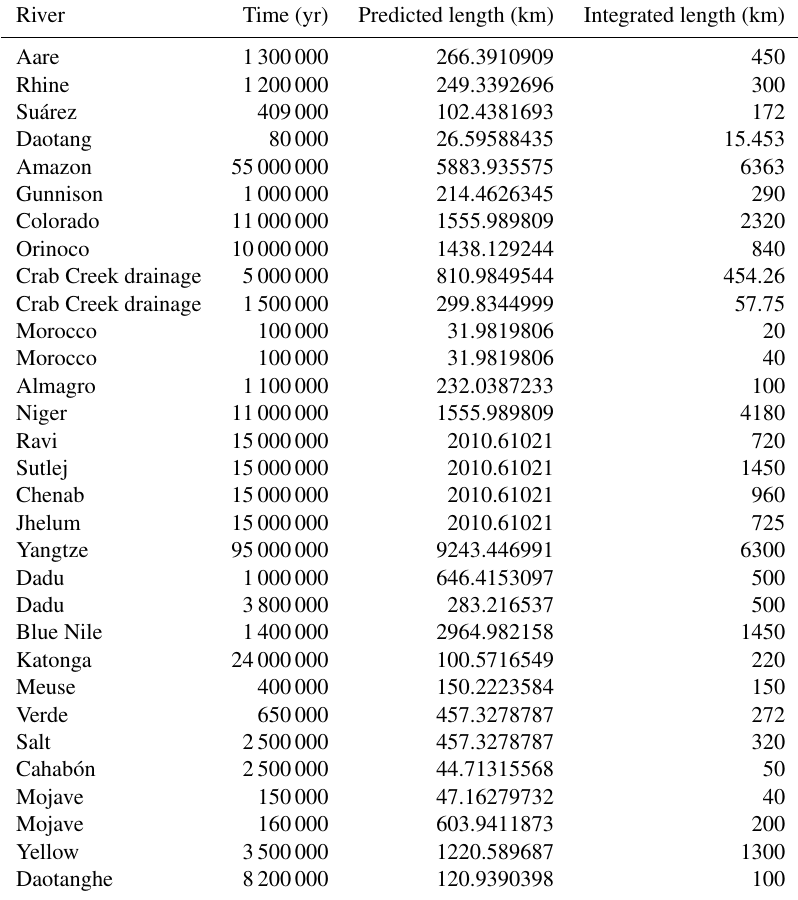
Table 1. Comparison of predicted and actual river